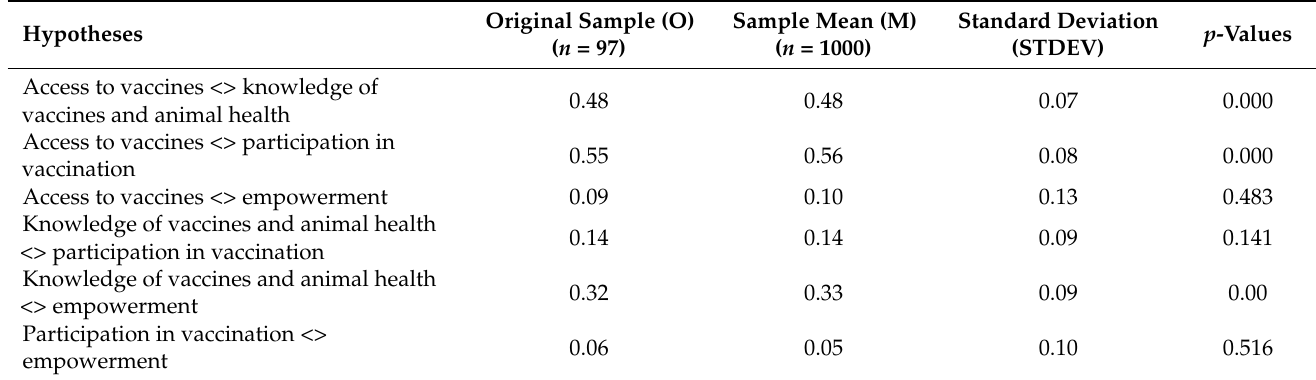
Table 5. Direct relationships (hypothesis) and mediation analysis (standardized path coefficients of latent variables for overall sample) for